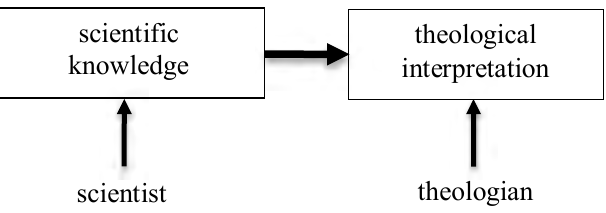
Figure 1: Series structure of the epistemology of miracle (semeiotic